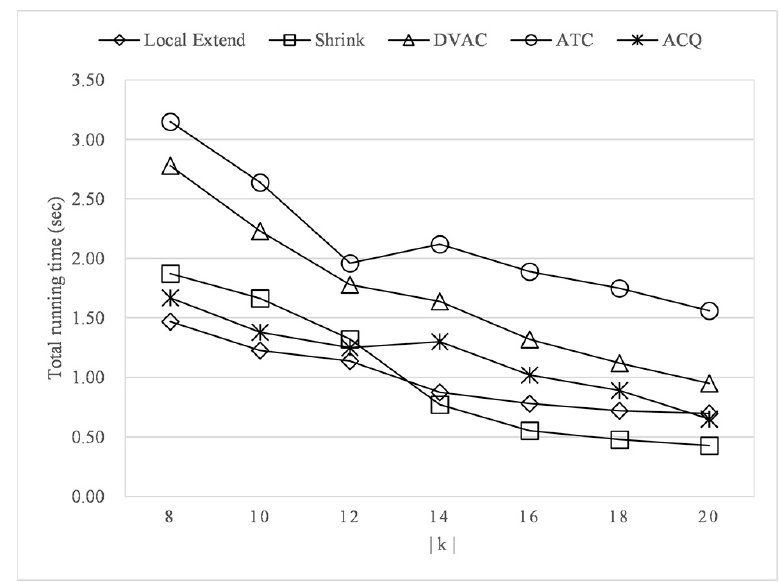
Figure 6. Efficiency evaluation of different models with different k.